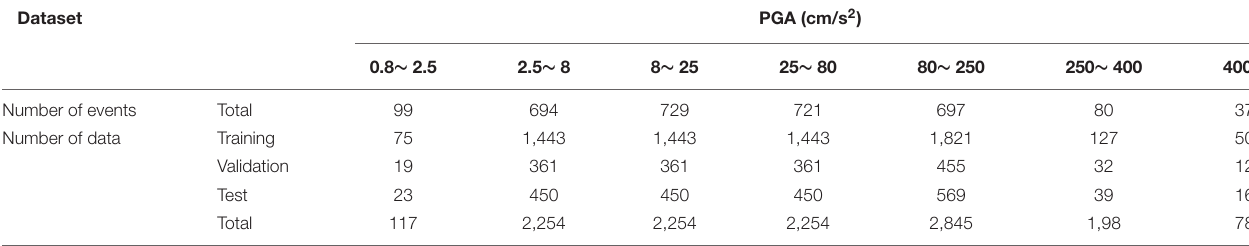
TABLE 2 | The 10,000 TSMIP earthquake data used for training, validating, and testing for the CNN.